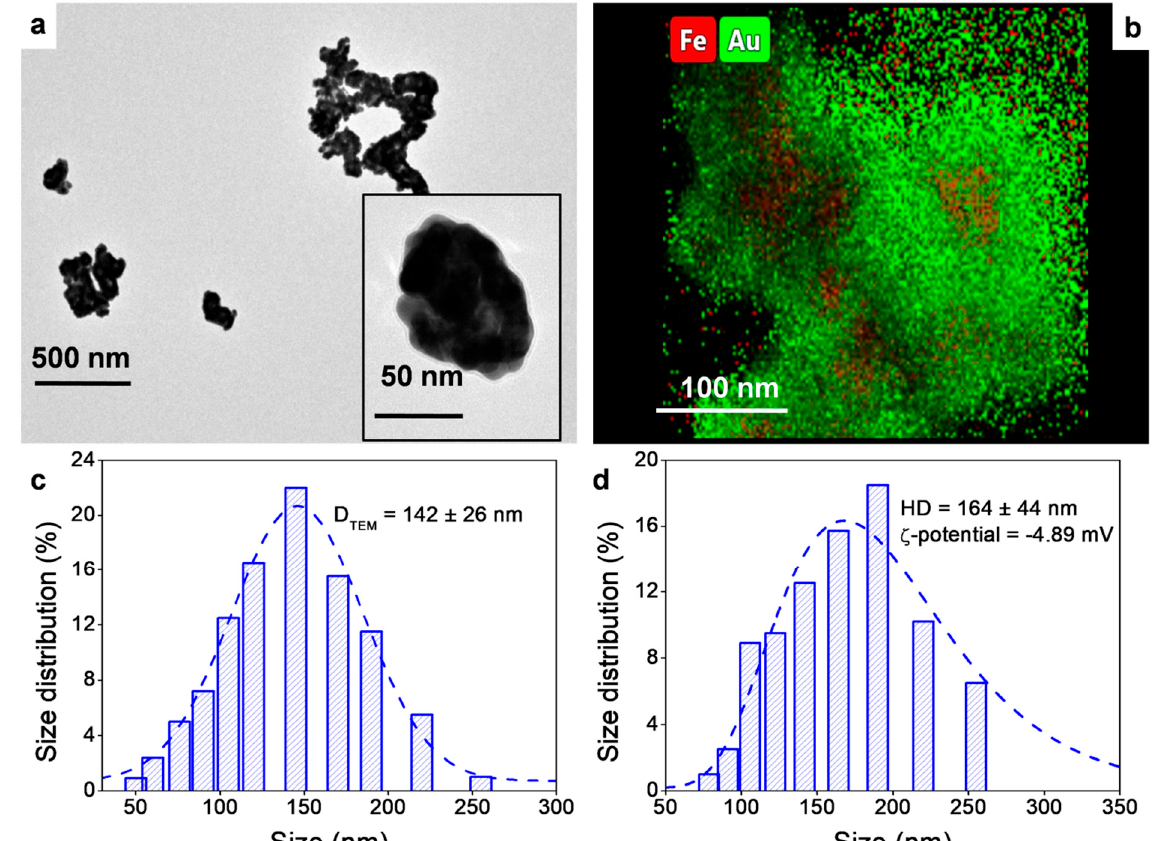
Figure 1. ( a ) Transmission electron microscopy images of the synthesized Fe@Au NPs. The inset is a 10× magnification of an isolated particle. ( b ) Spatial distribution of metal atoms in the NPs as measured by HAADF and EDX. ( c ) Size distribution obtained from the counting of 100 NPs in the TEM images. Gaussian fit is shown as a blue dashed line. ( d ) Size distribution and ζ -potential of the NPs suspension measured by DLS. Gaussian fit is shown as a blue dashed line.